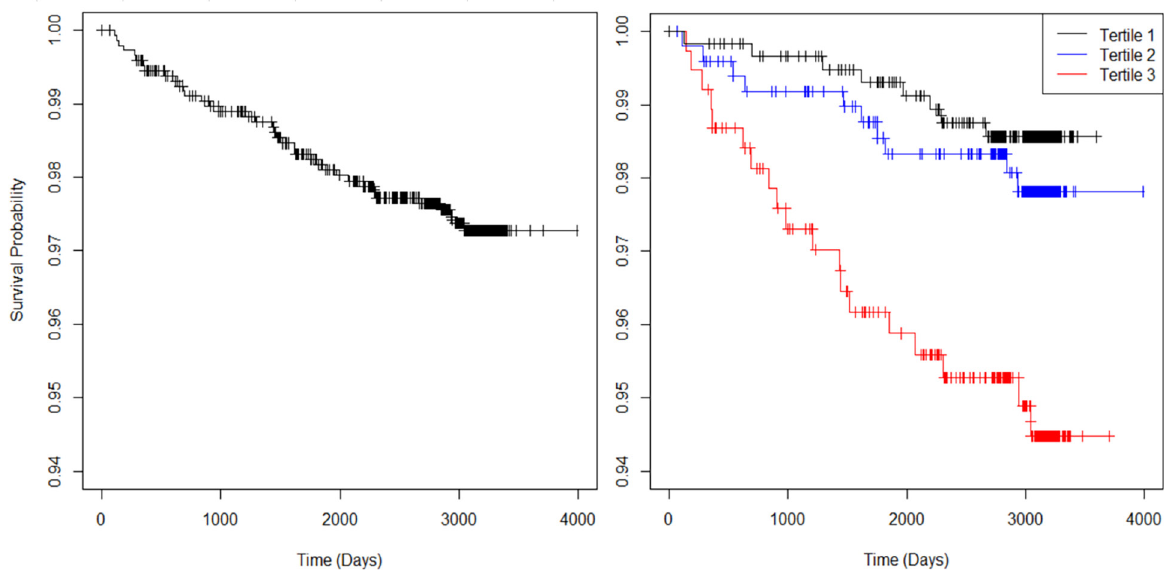
Figure 1. Kaplan-Meier curves with respect to all CVD events for all participants (left) and stratified by sTNFR-1 tertiles